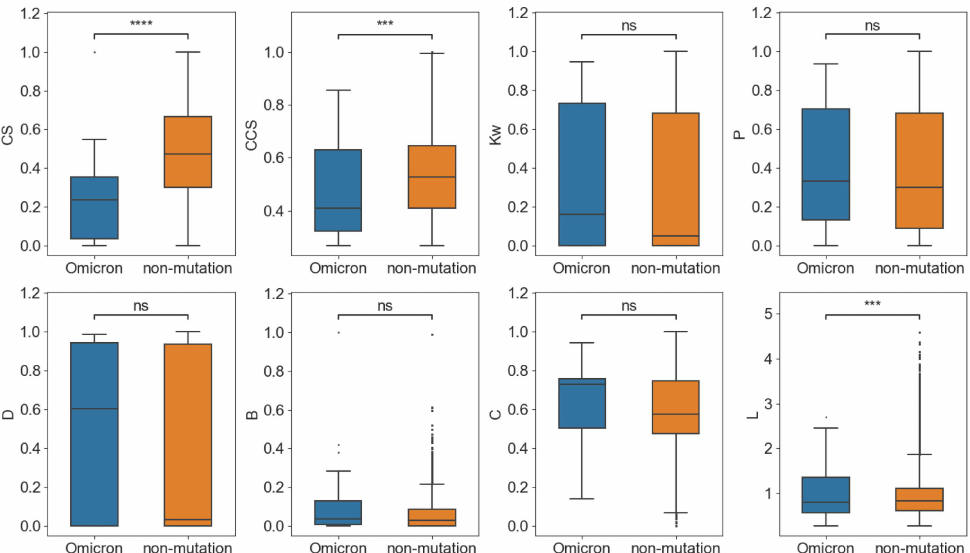
Figure 7. Comparison of the network features of Omicron BA.4 and the non-variant group. *** p < 0.001; **** p <